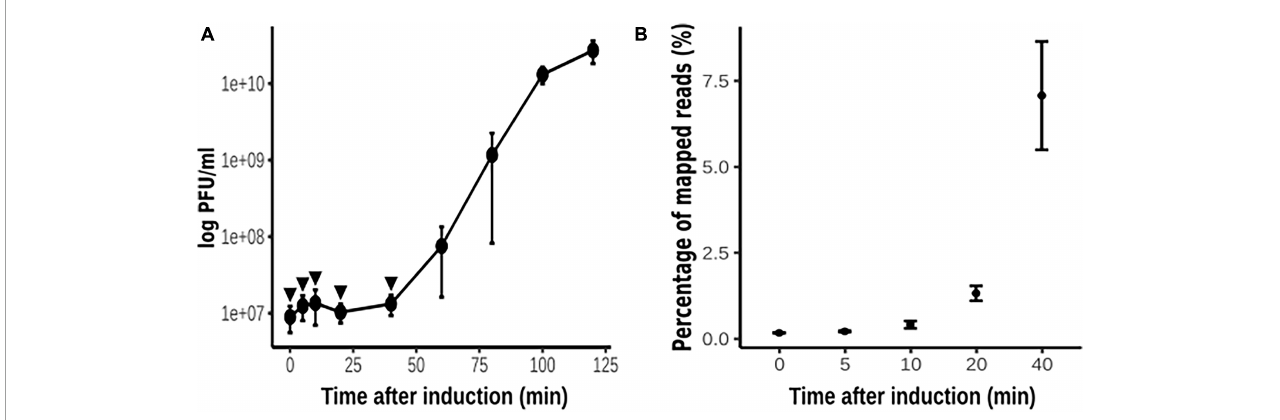
FIGURE2 Thermo-induction of lysogen PAO1(Fc02 repc ts). (A) Time course of the phage growth as measured by plaque forming units (pfu) on a lawn of strain PAO1. Three independent cultures of the lysogen were grown at 30 ◦ C to log phase, and at t = 0, each culture was up-shifted and incubated at 40 ◦ C for 2 h. Samples were drawn at the indicated times (filled circles) to quantify pfus. (B) Samples (arrowheads in A ) were drawn at the indicated times to be processed for strand-specific RNA-Seq (see Figure 3 ). Most of the reads were mapped to the bacterial sequences, but the percent of reads that were mapped to the phage genome is plotted against the time of thermo-induction. The average of the pfu/ml and the reads for the three biological replicas at each time were plotted and error bars indicate standard